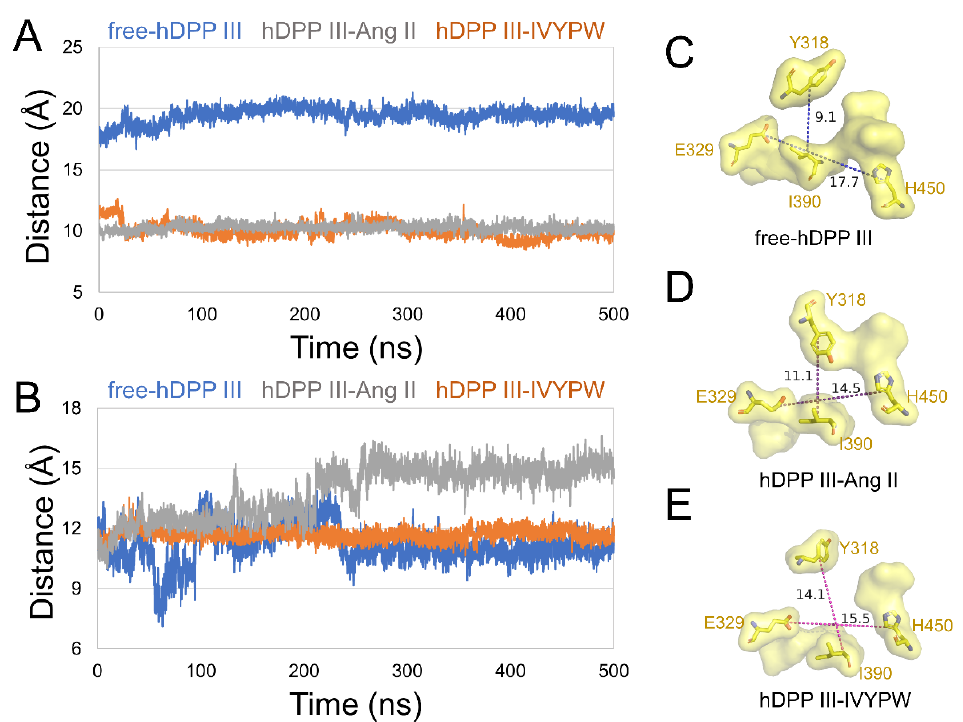
Figure 5. The distance of ( A ) Glu329-His450 and ( B ) Tyr318-Ile390 of subsite S1 in the three systems during 500 ns MD simulations. The surface form displays of subsite S1 in ( C ) free-hDPP III, ( D ) hDPP III-IVYPW, and ( E ) hDPP III-Ang II with residues Tyr318, Glu329, Ile390, and His450 shown as sticks and labeled.